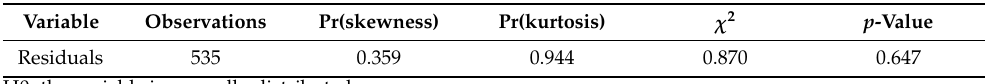
Table 5. The results of skewness/kurtosis tests for normality.